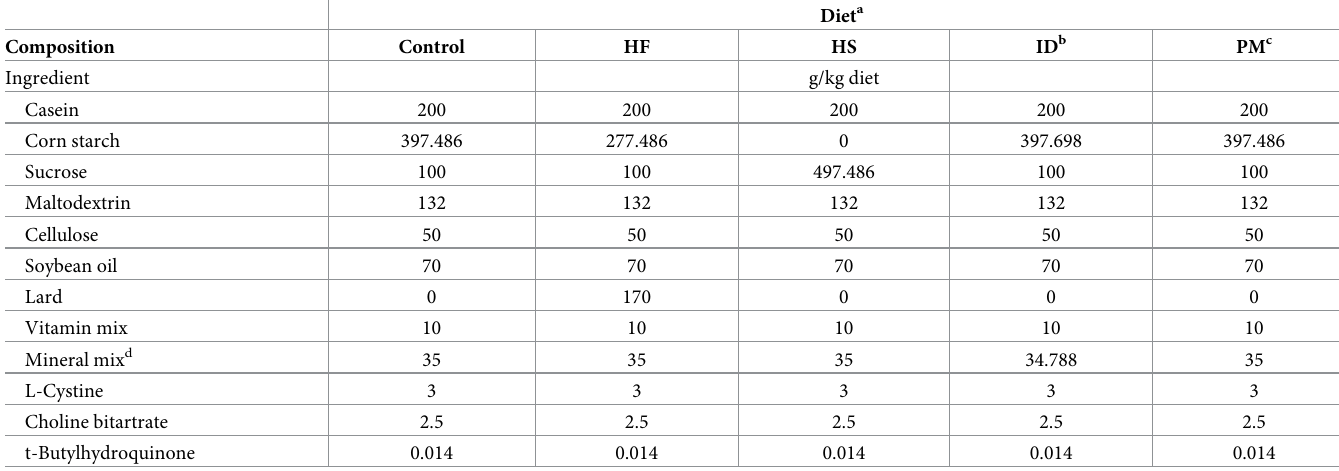
Table 1. Composition of the control and experimental diets.